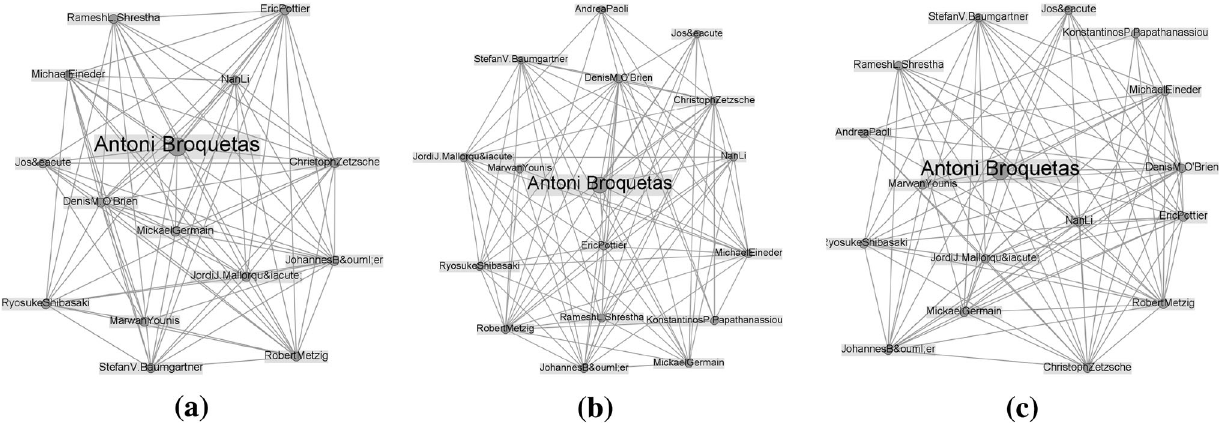
Fig. 9 Query node ‘‘Antoni Broquetas’’ in different models a (6-core with 15 nodes,82 edges). b (6-truss with 17 nodes,90 edges). c (6-core-truss 17 nodes,92 edges)